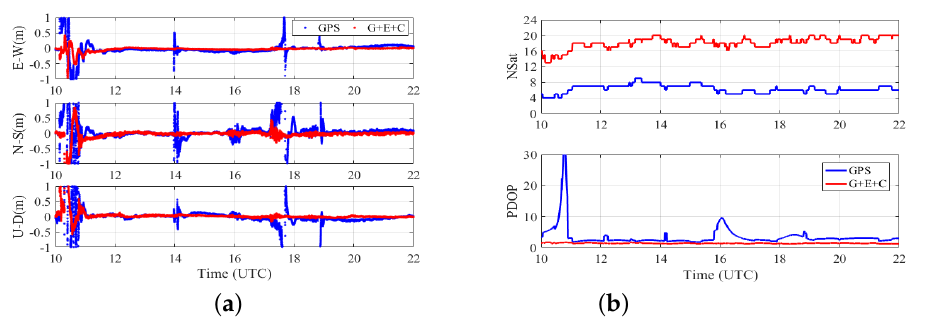
Figure 11. ( a ) DF RT–PPP position errors in the east, north, and up directions for GPS and multi–GNSS; and ( b ) NSAT and PDOP values for GPS and multi–GNSS from 10:00 to 22:00 on 12 September